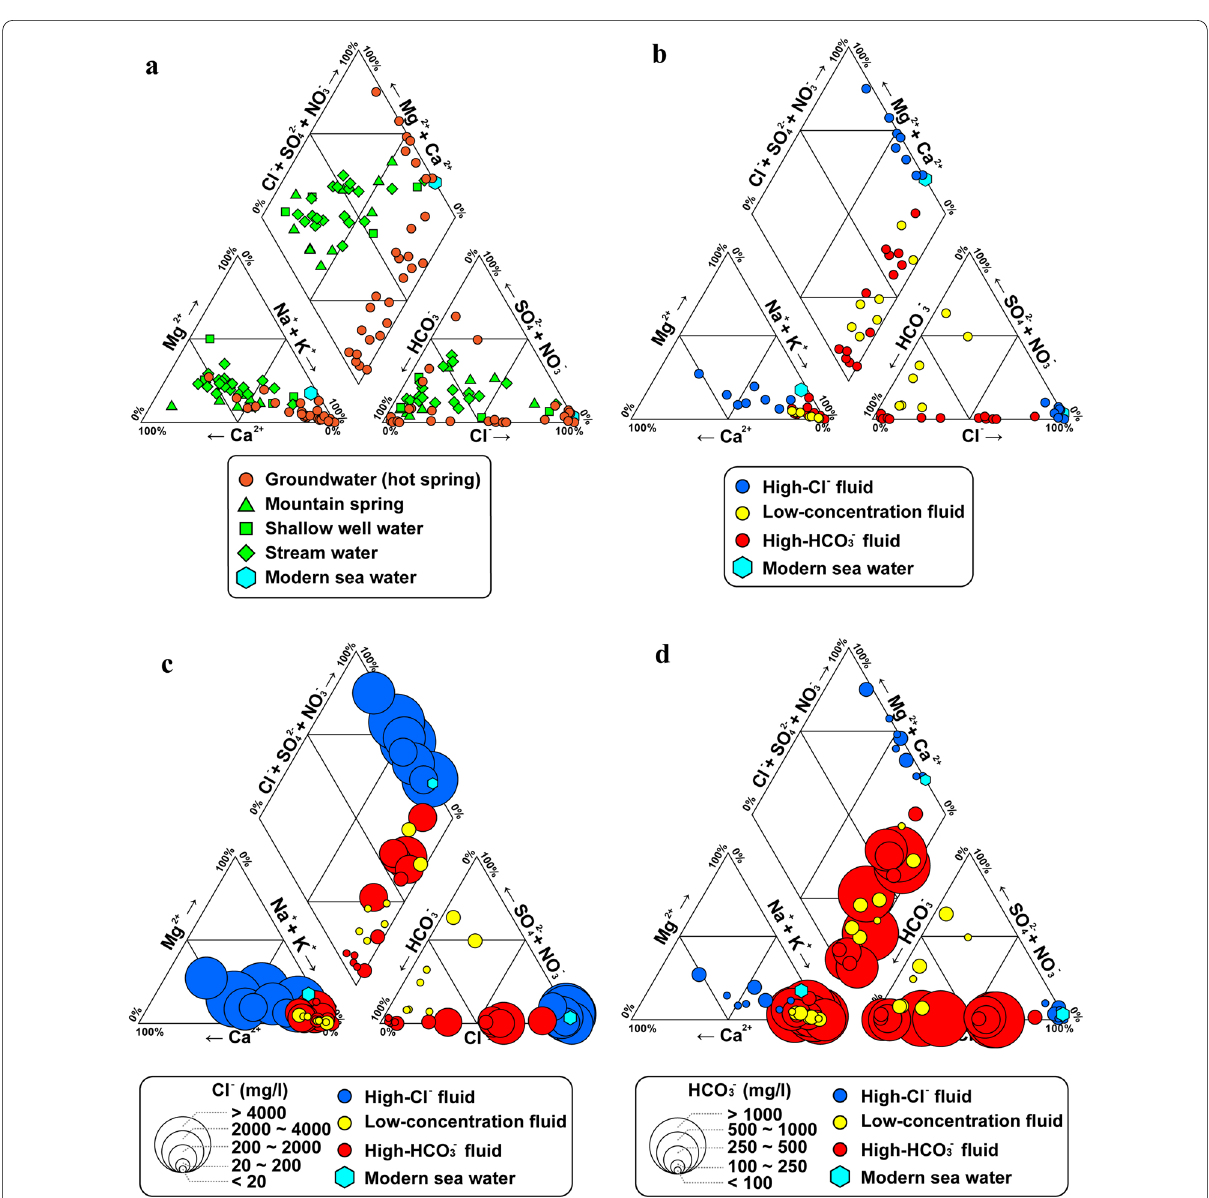
Fig. 2 Hydrochemical classification based on trilinear diagram. a Comparison between surface waters and groundwaters from hot spring sites. b Classification of three different types of groundwaters from hot spring sites. c Difference in Cl − concentrations among three types of fluids. d Diversity in HCO 3 − concentrations among three types of